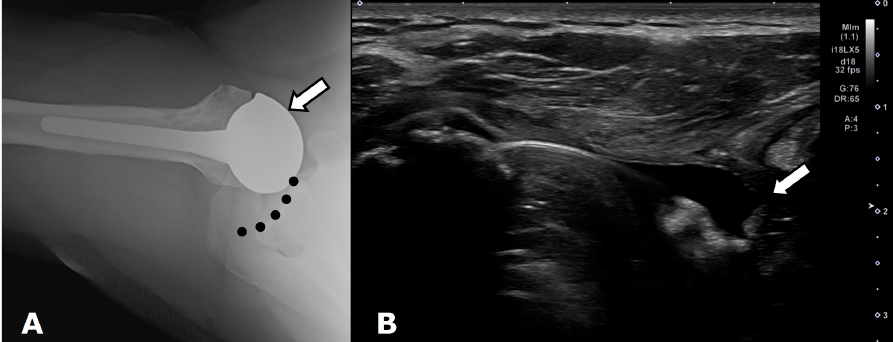
Figure 21. ( A ). Axillary radiograph shows anterior subluxation of the humeral head (arrow) component of the HA from the glenoid (do tt ed line) in a patient with subscapularis insu ffi ciency. ( B ). Long-axis US image (lateral image left, medial image right) in a di ff erent patient with an ATSA shows a full thickness subscapularis tendon tear with a retracted tendon stump (arrow).